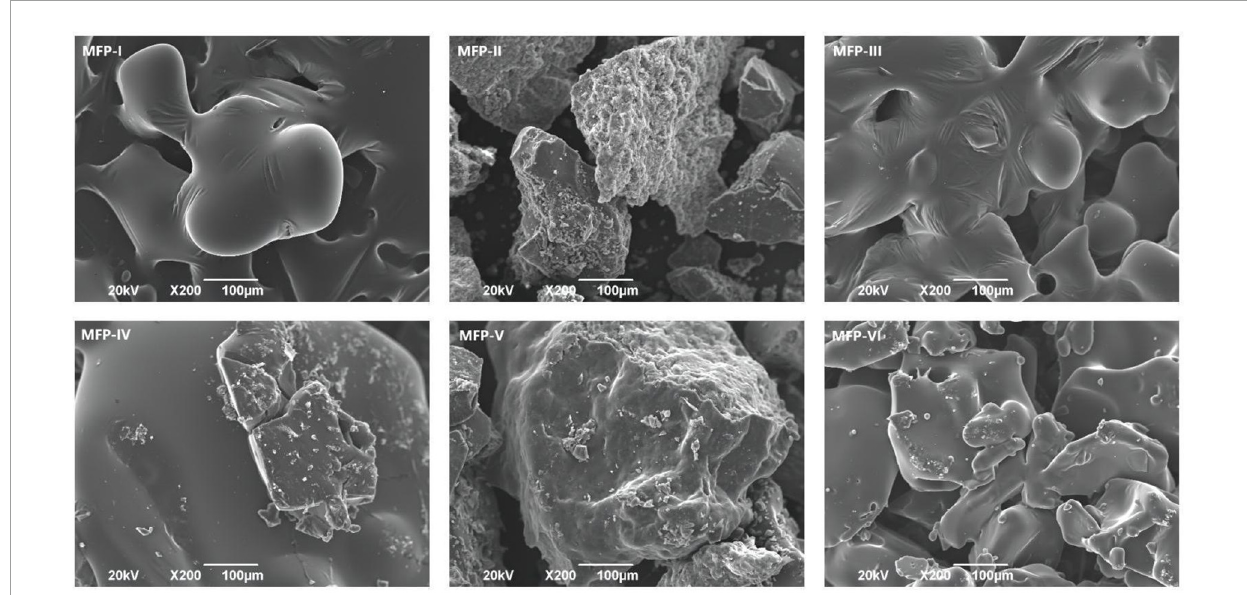
FIGURE7 SEM images of mulberry polysaccharide samples prepared by different extraction methods.